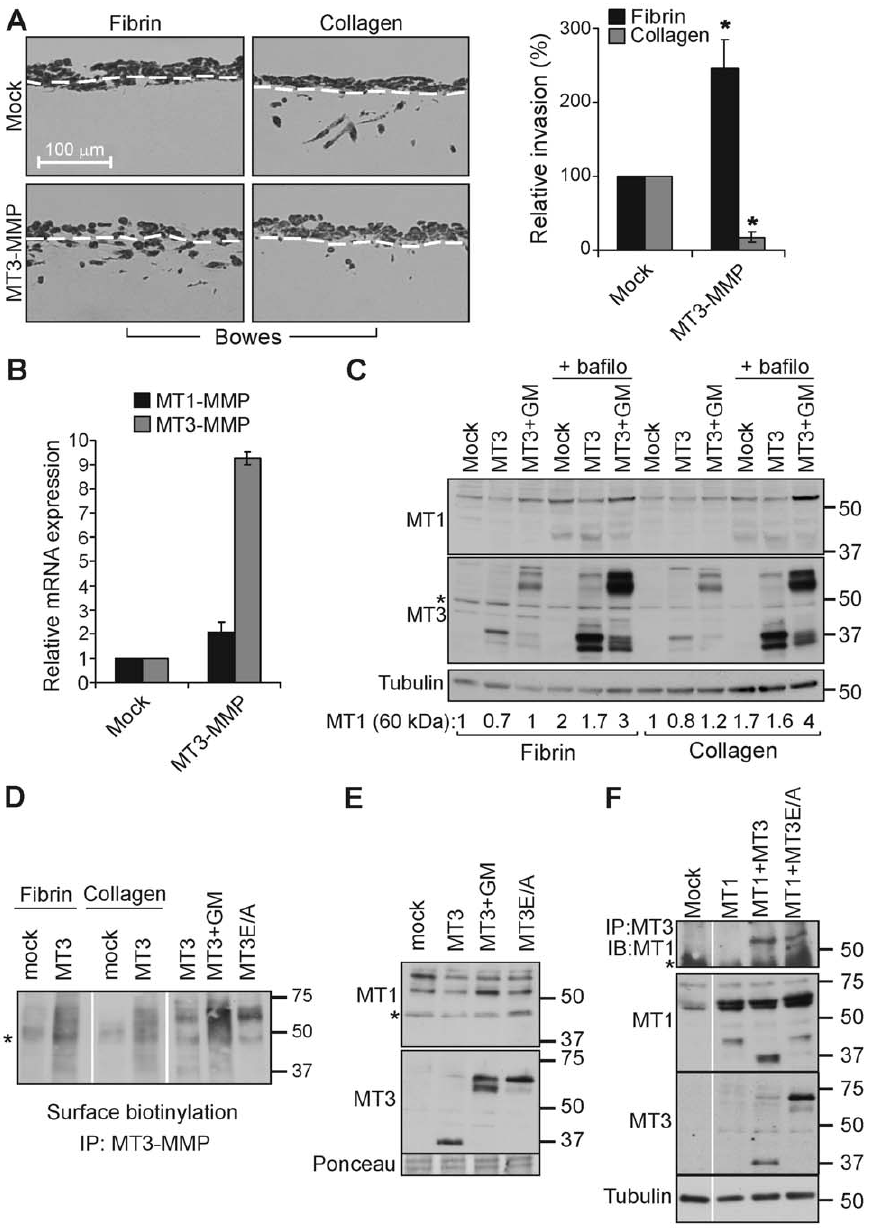
Figure 4. MT3-MMP induces fibrin invasion but inhibits collagen invasion of Bowes melanoma cells. (A) The stable cell pools transfected with MT3-MMP cDNA (MT3-MMP) or mock vector (Mock) were allowed to invade 3D fibrin or collagen gels for 5 d. Quantitative results are expressed as the number of invasive cells per microscopic field relative to the mock-transfected cells (n=3, *p=0.02). White dotted lines in the representative light micrographs of fibrin and collagen cross-sections mark the level below which the invaded cells were counted. (B) Chart shows average MT1- MMP and MT3-MMP mRNA expression relative to mock-transfected cells as assessed by qPCR. (C) The stable mock or MT3-MMP expressing cells were treated with GM6001 (10 m M) and bafilomycin A (100 nM) for 16 h as indicated, followed by MT3-MMP and MT1-MMP detection by immunoblotting. Full-length and processed forms of MT3-MMP were detected as 65/60 kDa and 37 kDa bands, respectively, and MT1-MMP as 60 kDa and 37–43 kDa bands. Tubulin served as a loading control. Asterix marks a non-specific band. (D) Cell surface MT3-MMP was detected by surface biotinylation of the stable cells on fibrin and collagen or cells transfected with cDNA for MT3-MMP or catalytically inactive MT3-MMP (MT3E/A) followed by MT3-MMP immunoprecipitation and detection with peroxidase-conjugated streptavidin. Cells were treated with GM6001 (10 m M) for 16 h prior to surface biotinylation where indicated. Asterix marks a non-specific band. (E–F) Bowes cells expressing the indicated cDNAs were lysed, followed by immunoblotting or immunoprecipitation. GM6001 (GM, 10 m M) was added where indicated. Ponceau staining and tubulin served as a loading control. Asterix marks non-specific bands. doi:10.1371/journal.pone.0028325.g004 MT3-MMP, or both proteases in combination. Consistent with the ability to invade fibrin gels and displayed additive effects when the fact that both MT1-MMP and MT3-MMP can degrade fibrin co-expressed (Fig. 5A). In contrast, while MT1-MMP alone [18], either MT1-MMP or MT3-MMP conferred the cells with induced COS-1 cell invasion into collagen matrices, MT3-MMP,